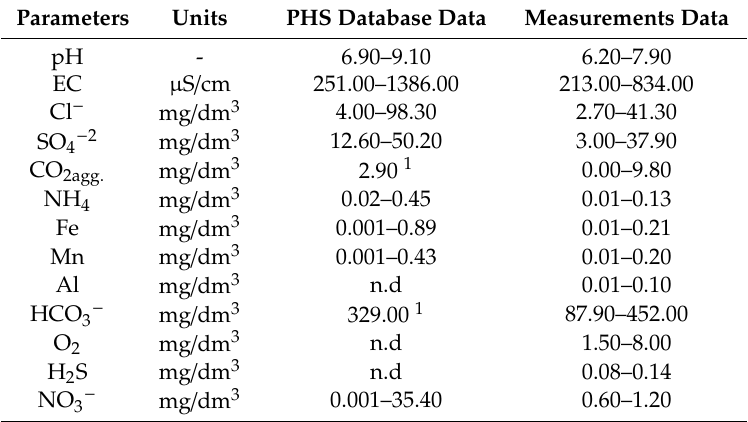
Table 3. Values of physicochemical parameters of the analyzed groundwater.